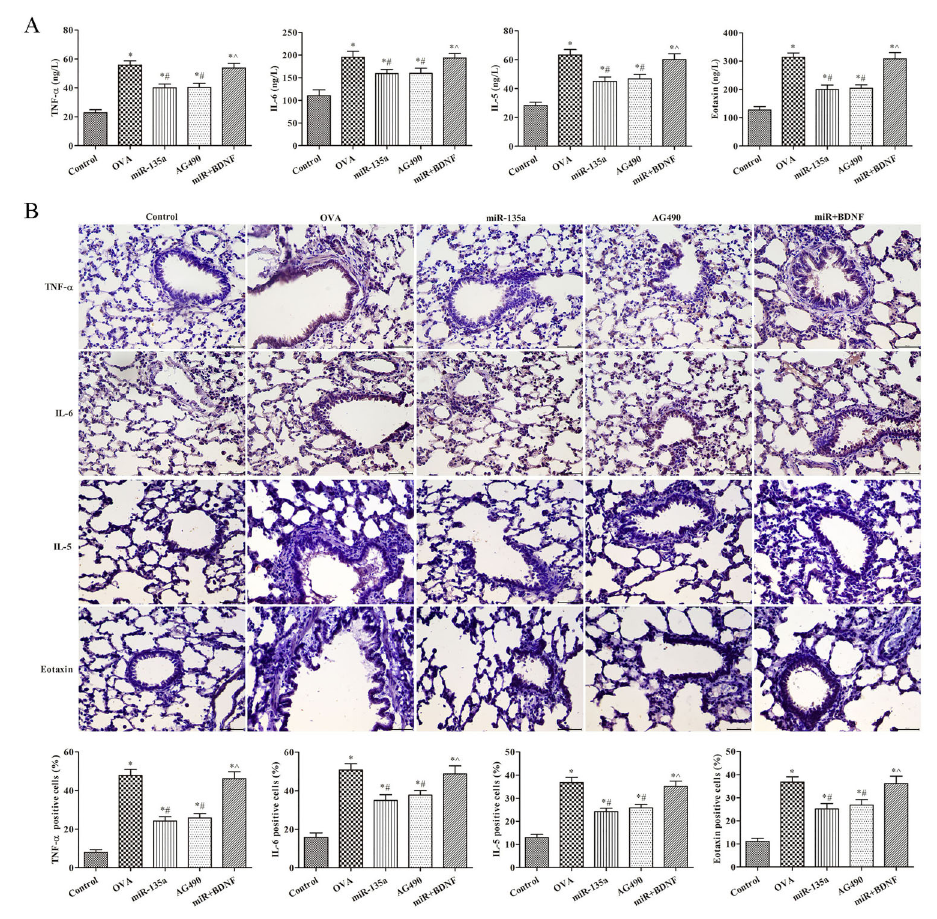
Figure 7. Effect of JAK/STAT signaling pathway on the expression of tumor necrosis factor (TNF)- a , interleukin (IL)-6, IL-5, and eotaxin in lung tissue of mice. A , The levels of TNF- a , IL-6, IL-5, and eotaxin in bronchoalveolar lavage fl uid were detected by ELISA, and B , in lung tissue of mice by immunohistochemistry ( (cid:2) 400). Data are reported as means ± SD. *P o 0.05 compared to the control group; # P o 0.05 compared to the ovalbumin (OVA) group; ̂ P o 0.05 compared with the miR-135a group